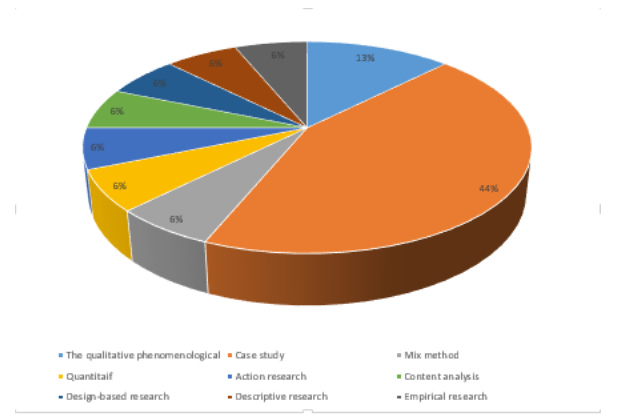
Figure 4: The distribution of technological integration forms